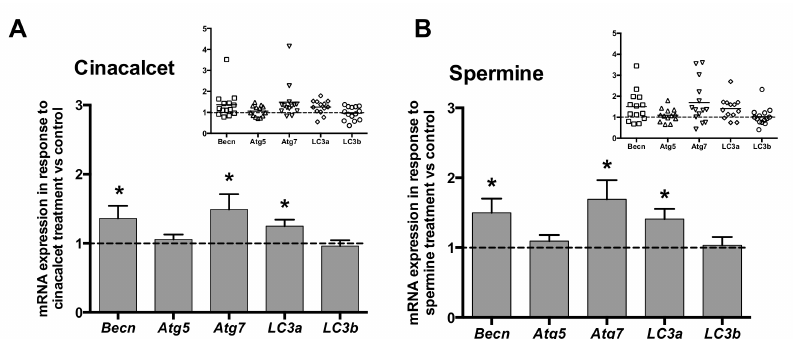
Figure 2. Expression (mRNA) of the autophagy genes becn , atg7 and lc3a is upregulated by CaSR activators in whole adipose tissue explants. mRNA content was determined by qPCR after 6 h treatment with ( A ) 2 µ M cinacalcet or ( B ) 100 µ M spermine. mRNA expression is expressed normalized by the internal reference gene GAPDH and presented as a fold of vehicle-treated controls (dotted line, 1). * p < 0.05 for the di ff erence from 1, Wilcoxon signed rank test, n = 13 independent donors’ explants. The insets show the individual experimental data.